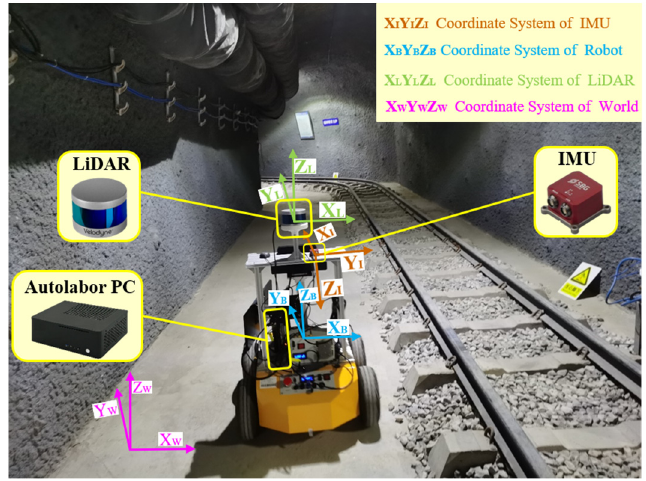
Figure 1 . Data acquisition platform and environment. Table 1 . Specifications of data acquisition platform. Table 1. Specifications of data acquisition